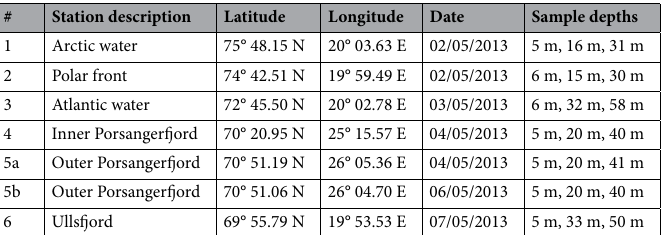
Table 1. Overview of sample location, date (dd/mm/yyyy) and water depth of all seven PHAEONIGMA stations within the Barents Sea and adjacent North Norwegian